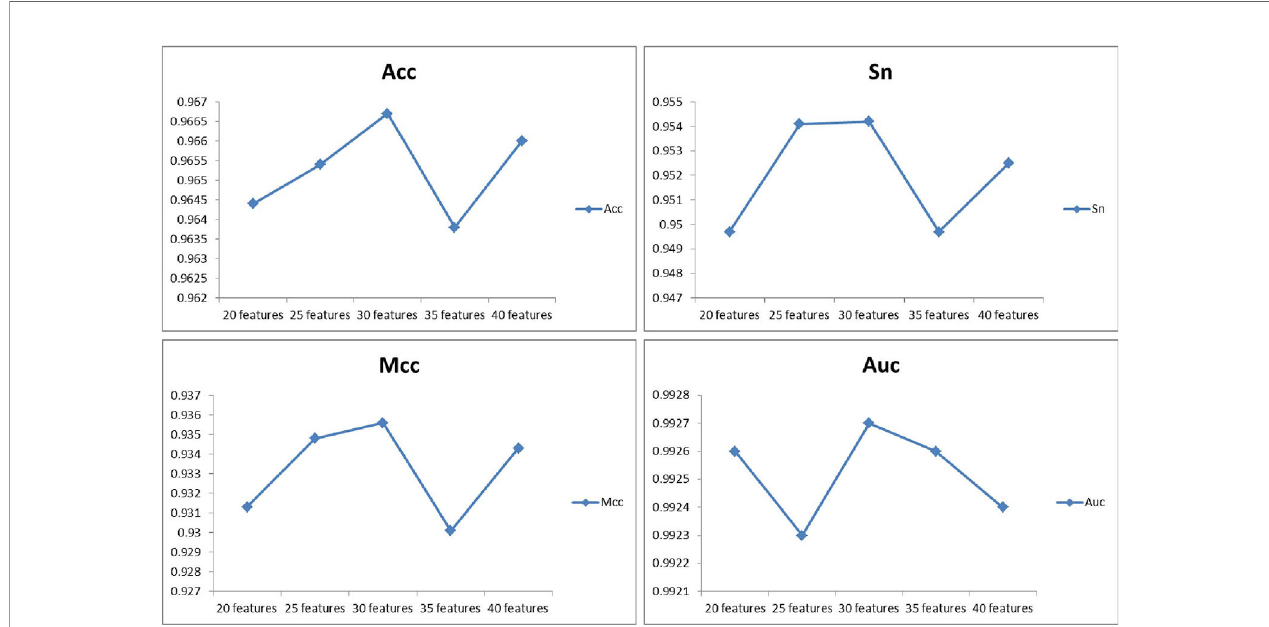
FIGURE 3 | The comparison of the effects of different feature numbers based on principal component analysis